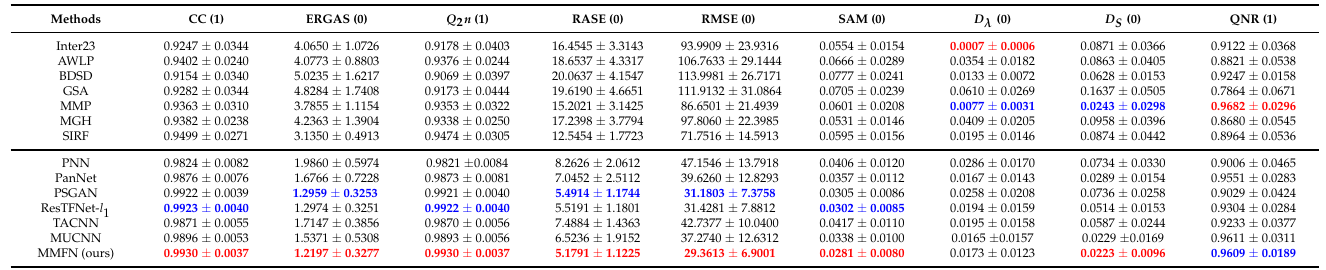
Table 3. Average quantitative performance on the Pléiades dataset. The best and second best performances are shown in Red and Blue , respectively.